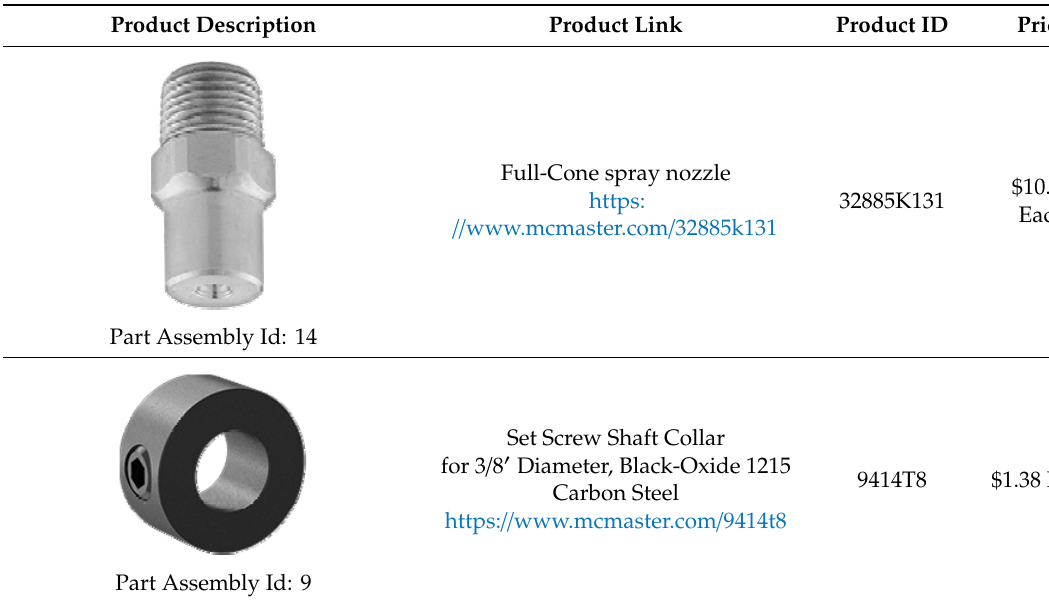
Table 2. Bill of Materials (from McMaster